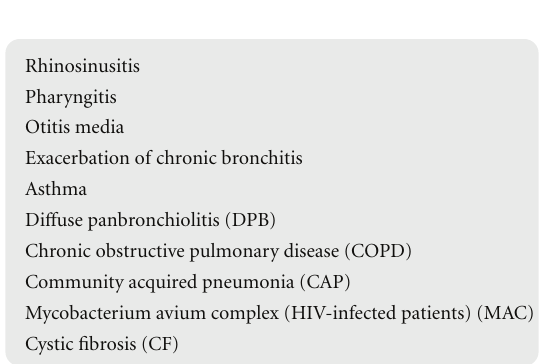
Figure 4: Airway diseases in which macrolides are indicated.